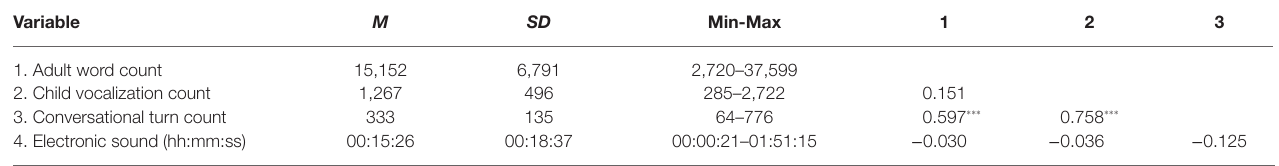
TABLE 1 | Language ENvironment Analysis (LENA) variables of interest, mean, standard deviation, Min, Max, and Pearson’s correlations. Variable M SD